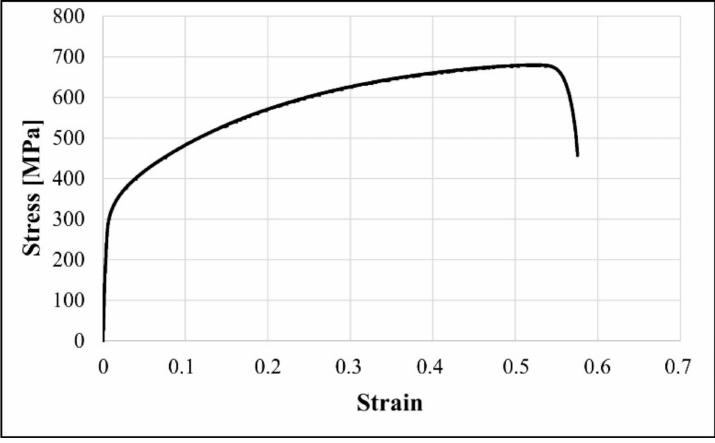
Figure 2. Stress-strain curve of the Fe-21.2Mn-2.73Al-2.99Si steel registered at room temperature.